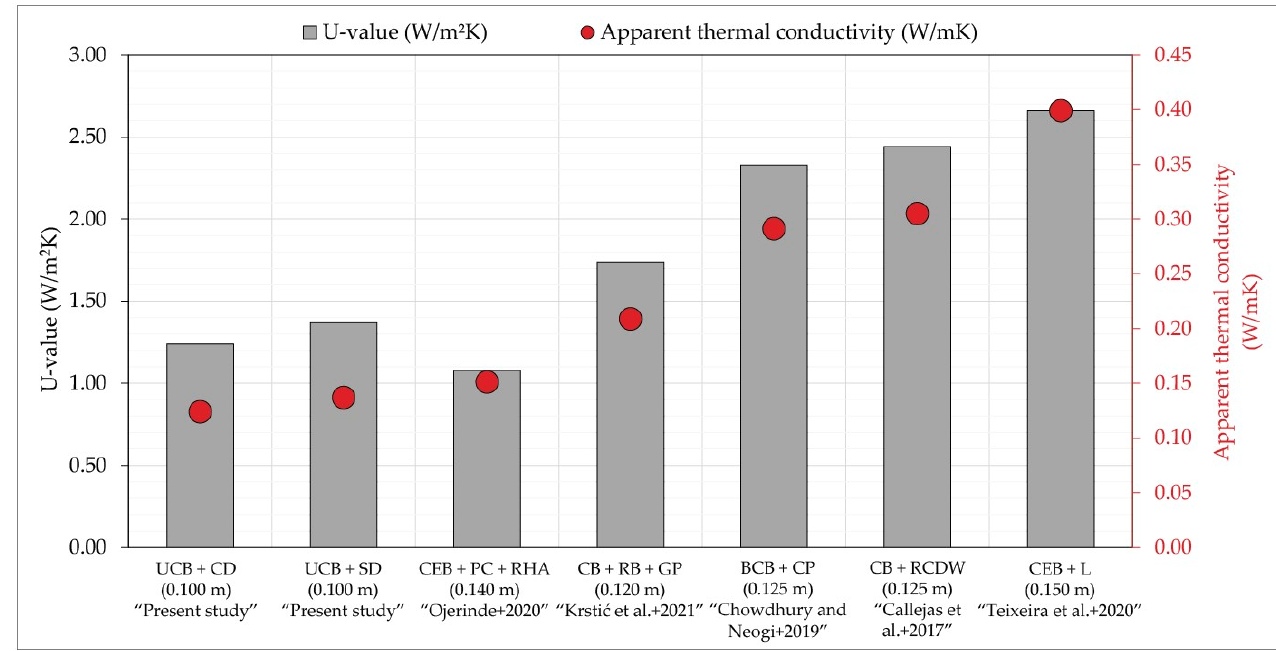
Figure 13. Comparison of U-values of different walls with literature results [90–94].